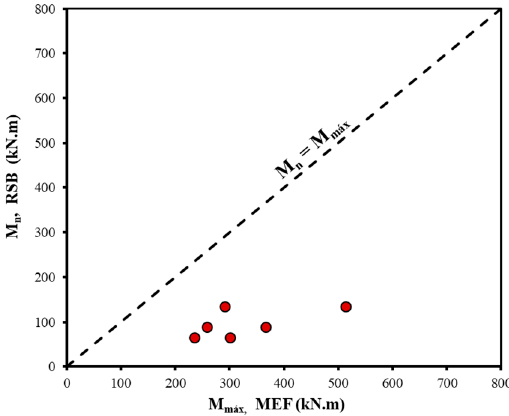
Figure 9. Comparison of FEM results with estimations of the rectangular stress block (RSB) method.